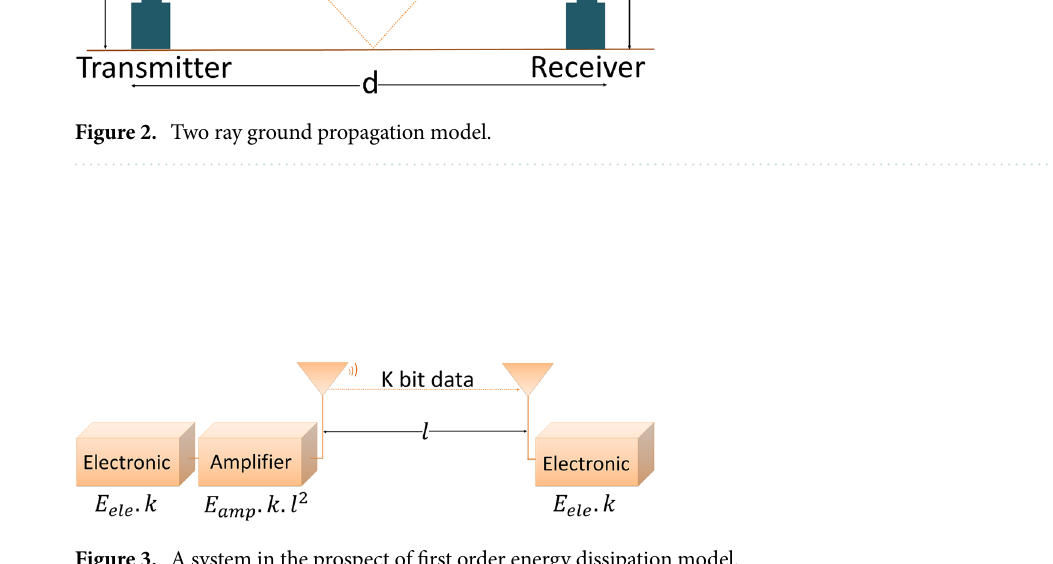
Figure 3. A system in the prospect of first order energy dissipation